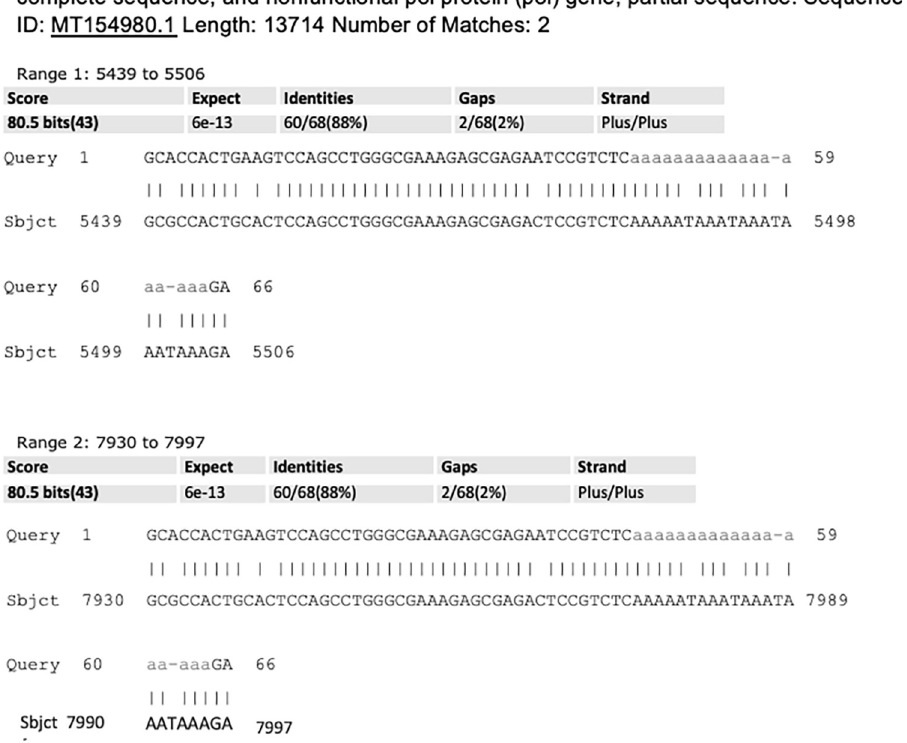
Fig 10. Standard BLAST analysis of GBM exosomal DNA clone after omitting the sequences identical to pCR4TOPO-TA vector and NANOG/NANOGP8 gDNA. The remaining sequence reveals the identities with HIV-1